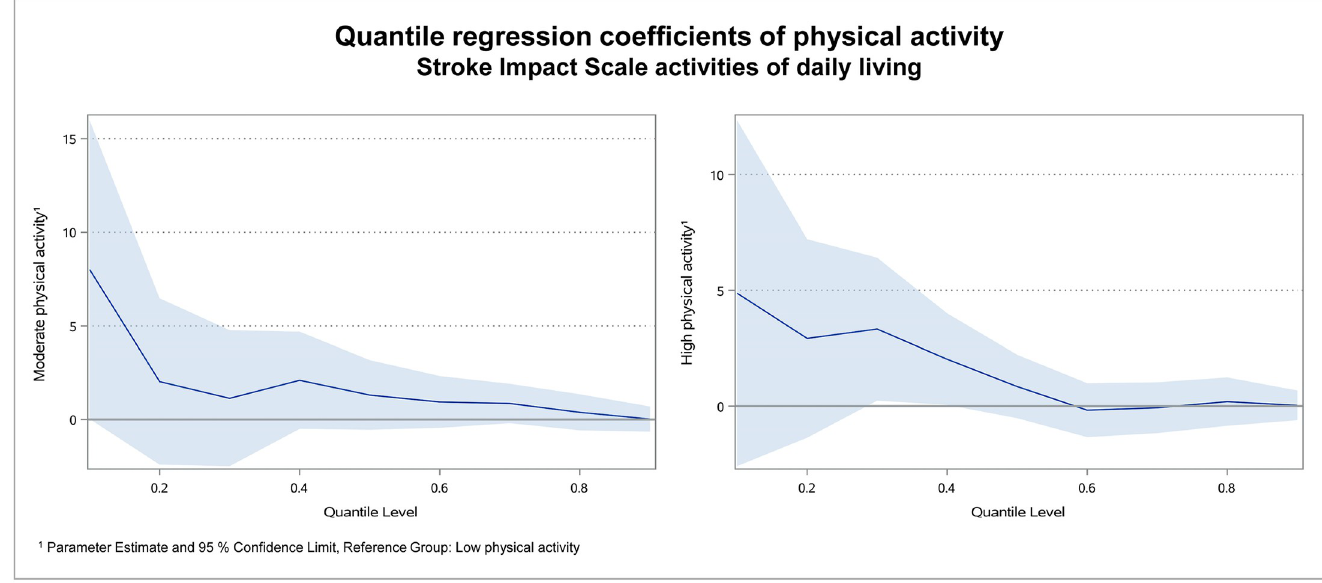
Fig 5. Quantile regression coefficients of physical activity for SIS activities of daily living. In the subdomain activities of daily living, the coefficient of moderate physical activity was 8.0 in quantile 0.1, while it was 2.1 or smaller in all other quantiles. For high physical activity the coefficient was 4.9 in quantile 0.1 and declined to 3.3 or smaller in all other quantiles. In the quantiles 0.6 and 0.7 it was slightly